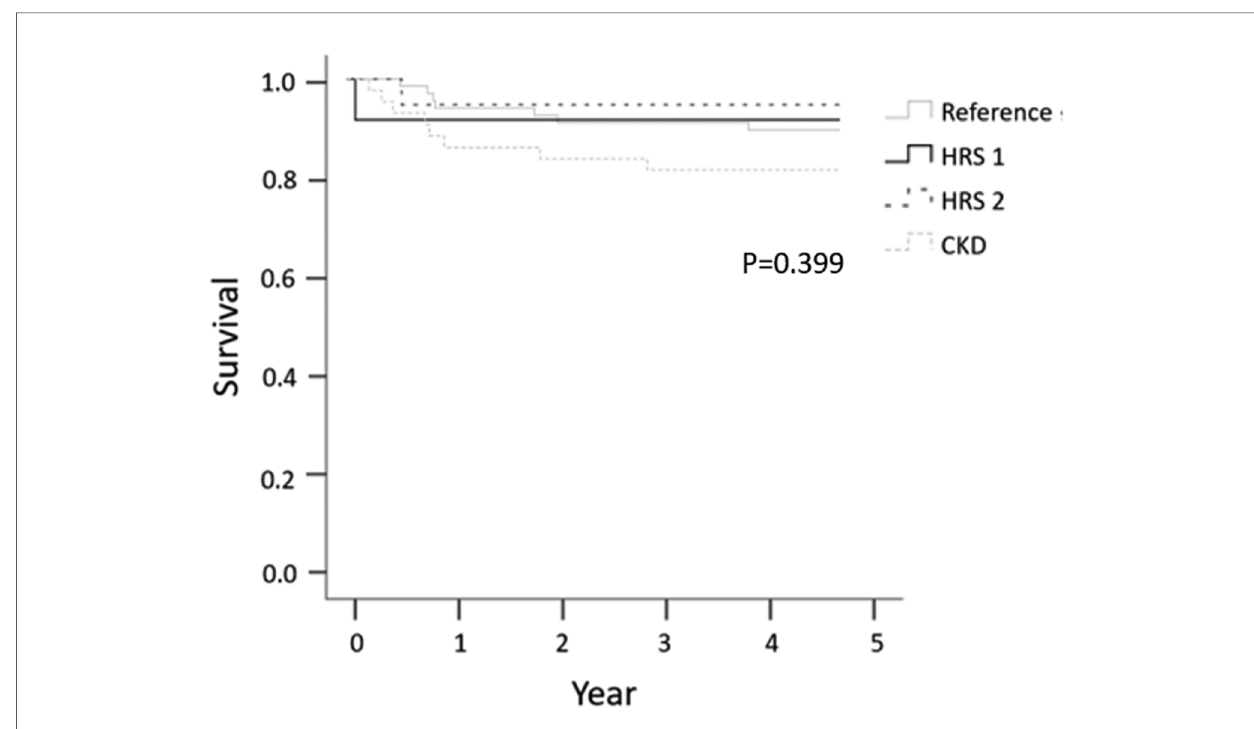
FIGURE 2 Five-year survival according to preoperative renal function, categorized by HRS1, HRS2, CKD, and reference groups.